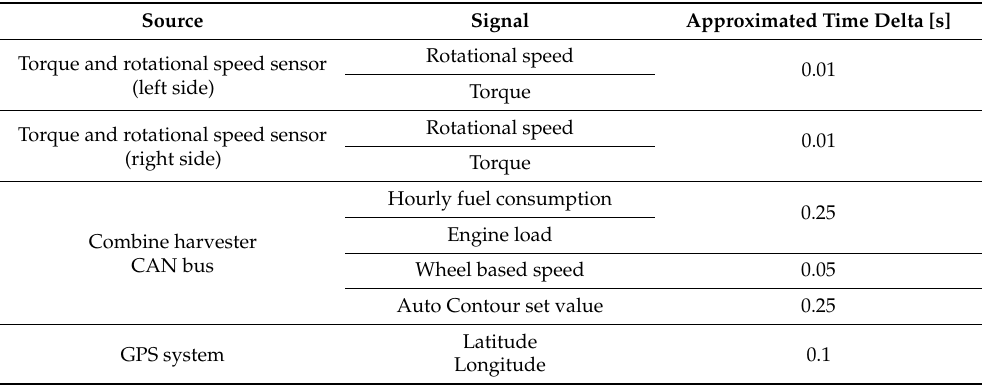
0.01 0.01 0.25 0.1